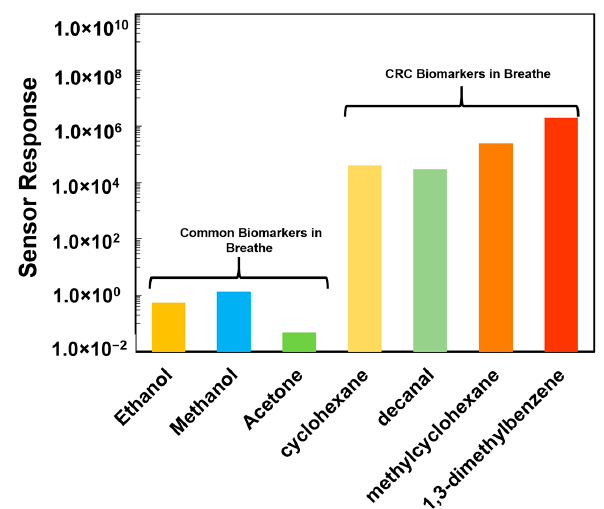
Figure 9. Sensor response of Ni-TNA when exposed to the common VOBs found in breath and signature biomarkers associated with CRC. A very low response was observed when exposed to the more common breath VOBs compared to the sensor response from the CRC biomarkers.